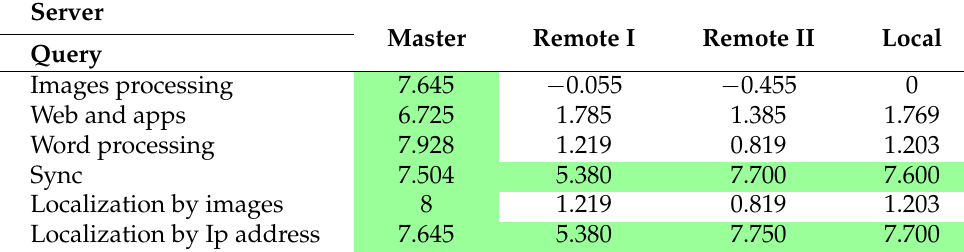
Table 16. Saaq score values for scenarios O3, O4, and O5.